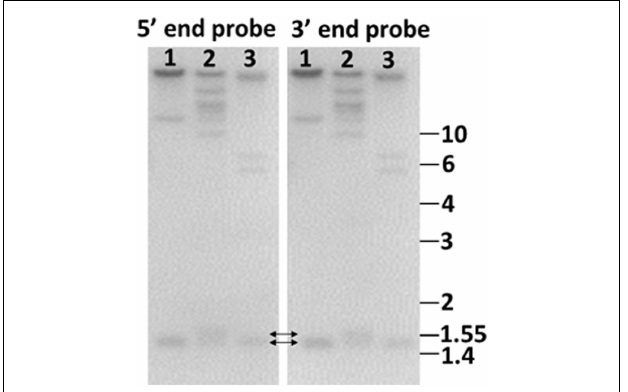
FIGURE 5 | Genome blot of Sp185/333 genes indicates that the genes are small. Probes for the 5 (cid:2) end and the 3 (cid:2) end of the second exon hybridize to the same bands.This includes bands that are 1.4–1.55kb (double headed arrows), demonstrating that the genes are small. Genomic DNA from three sea urchins (1, 2, 3) was digested to completion with Pst I and separated by electrophoresis. Duplicate gels were blotted onto nylon membranes and analyzed with 32 P-labeled riboprobes according to Terwilliger et al. (2006). Cloned templates used to generate the riboprobes were amplified by PCR from genomic DNA using primers that hybridized to elements 1 and 7 (5 (cid:2) probe), and elements 7 and 25 (3 (cid:2) probe). See Figure 6A for element positions. Size standards in kilobase are shown to the right. (Terwilliger and Smith,